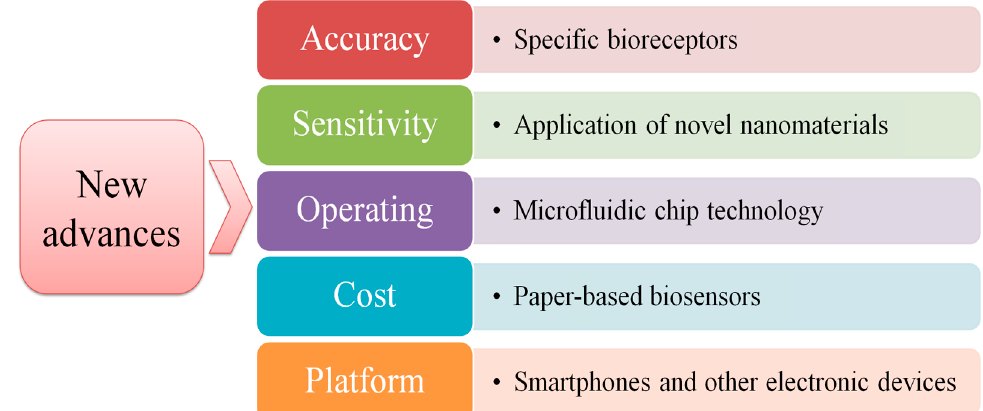
Figure 12. New advances of biosensors.